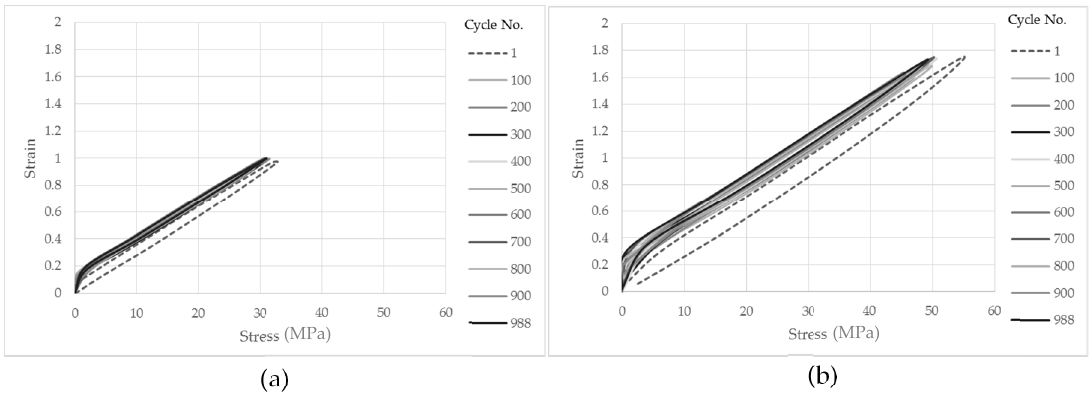
Figure 13. Stress–strain plot at selected cycles from fatigue testing at ( a ) 1% strain and ( b ) 1.75% strain. 1000 fatigue cycles conducted; selected cycles plotted here to identify any change in the POF properties.